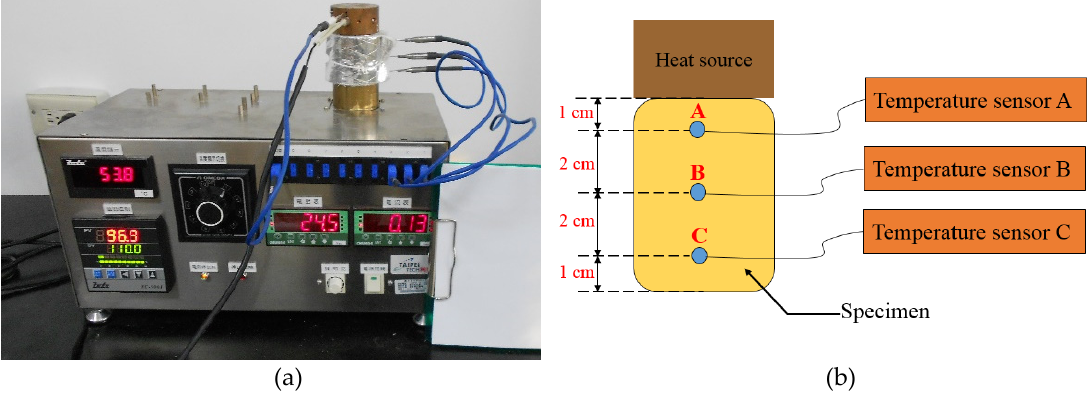
Figure 4. Illustration of the thermal conductivity test (SUS304, Xiwnag Jiazu LTD., Kaohsiung, Taiwan). ( a ) Thermal conductivity test setup; ( b ) Thermal conductivity test specimen.